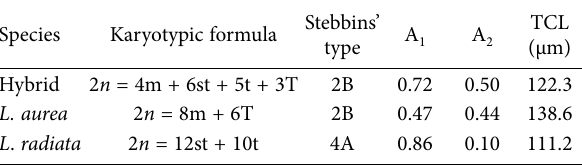
Table 1. Karyotype characteristics of the studied Lycoris taxa.